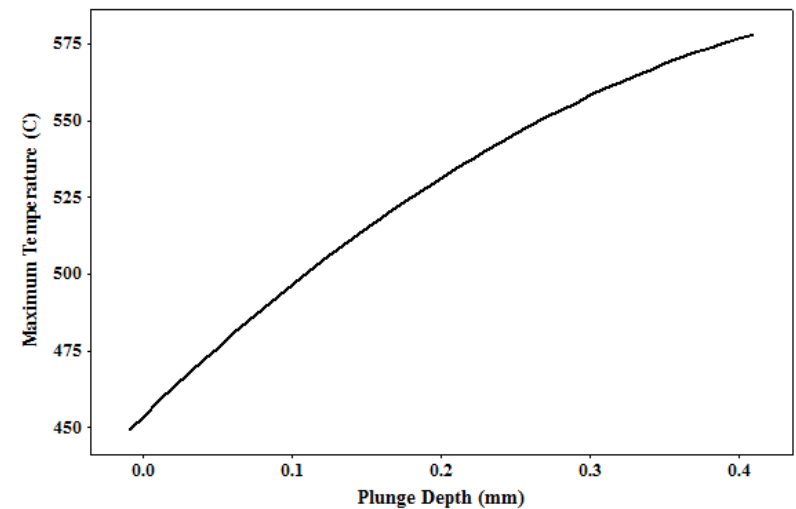
Figure 8. Maximum temperature vs. plunge depth for welded